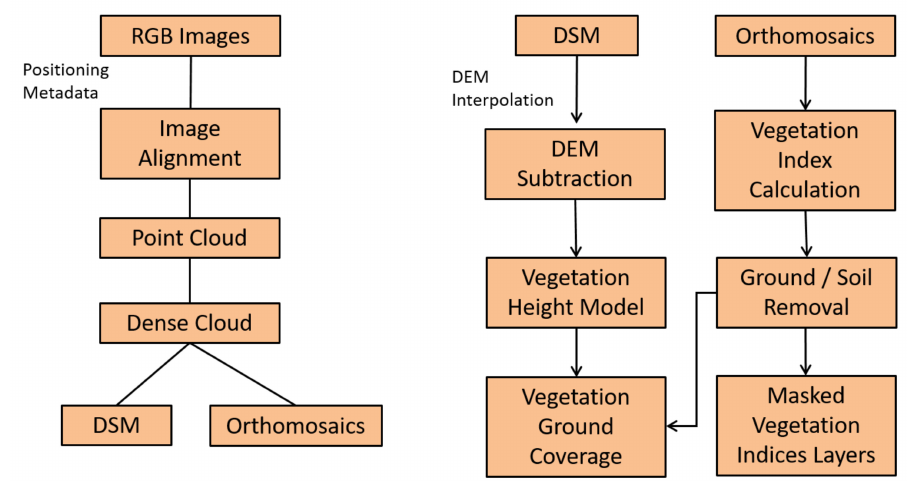
Figure 5. The data processing pipeline for the generation of the primary datasets of this study.